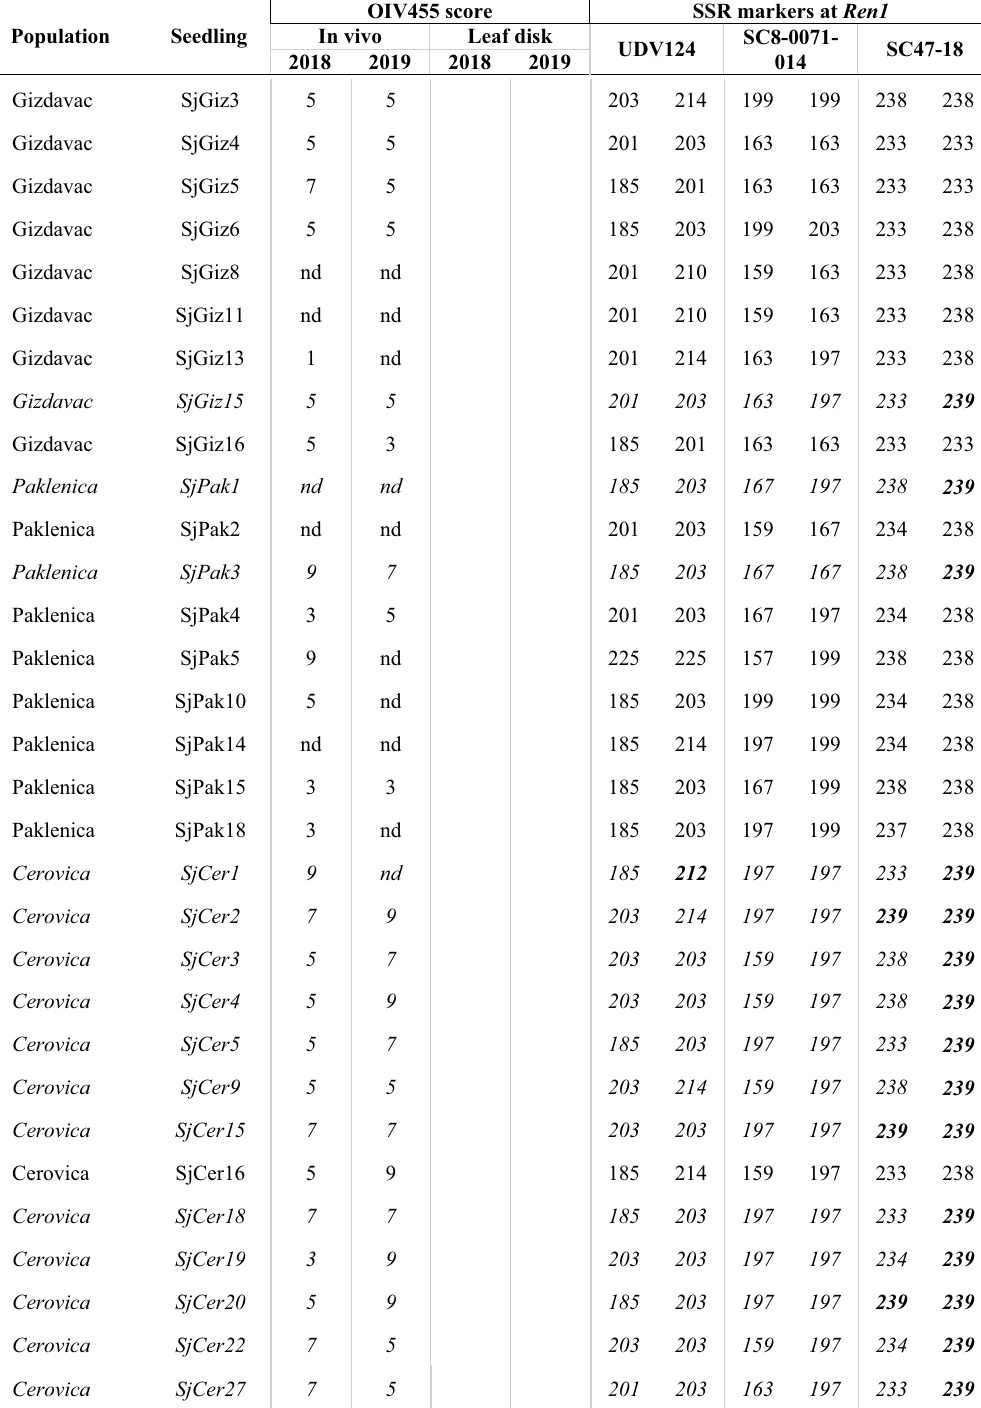
Table 1. Genetic polymorphism of 67 V. sylvestris seedlings at three SSR markers linked to the Ren1 locus on chromosome 13 and phenotypic powdery mildew results obtained from in vivo and leaf disk methods based on the OIV 455 descriptor scale from 1 (susceptible) to 9 (resistant) in 2018 and 2019. Dashed line separates seedlings based on phenotypic method used for their disease evaluation. For 10 seedlings, phenotypic results were not determined or not complete (‘nd’) as accessions dried or were too small for evaluation. Rows in italics individuals carrying R-alleles. Allele 239 at marker SC47-18 (in bold) was linked to resistance in V. sylvestris. Allele 212 at marker UDV124 (in bold) was linked to resistance in V. vinifera 7